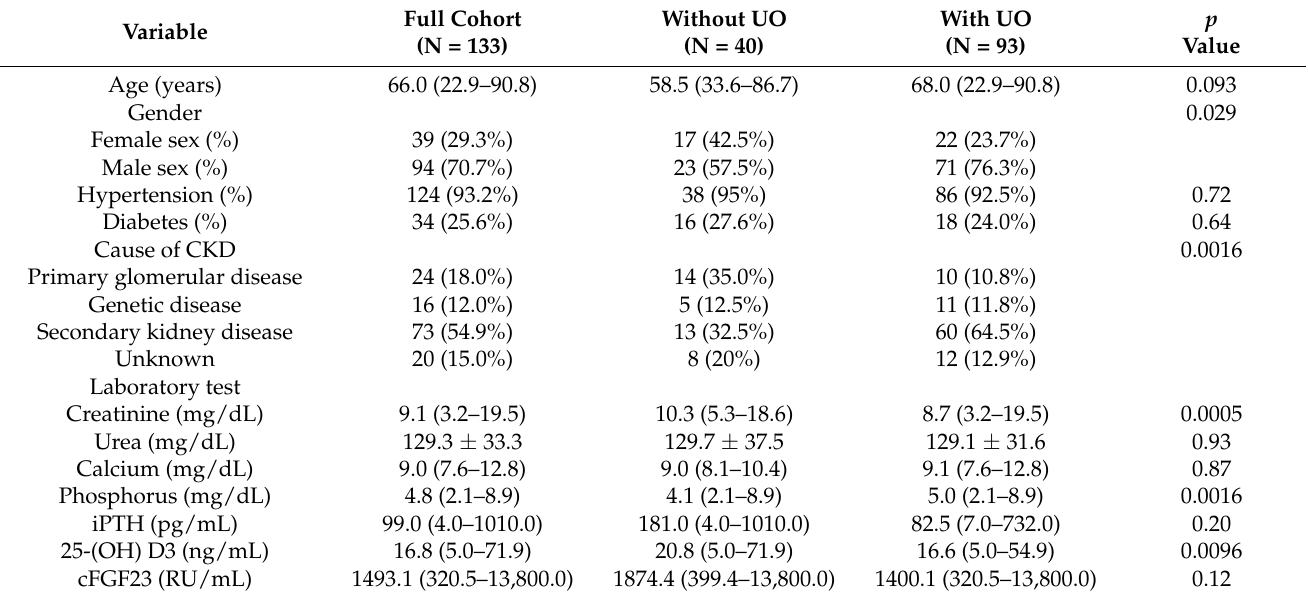
Table 2. Characteristics of the full cohort, without the residual urine output (without UO) and with the residual urine output (with UO)